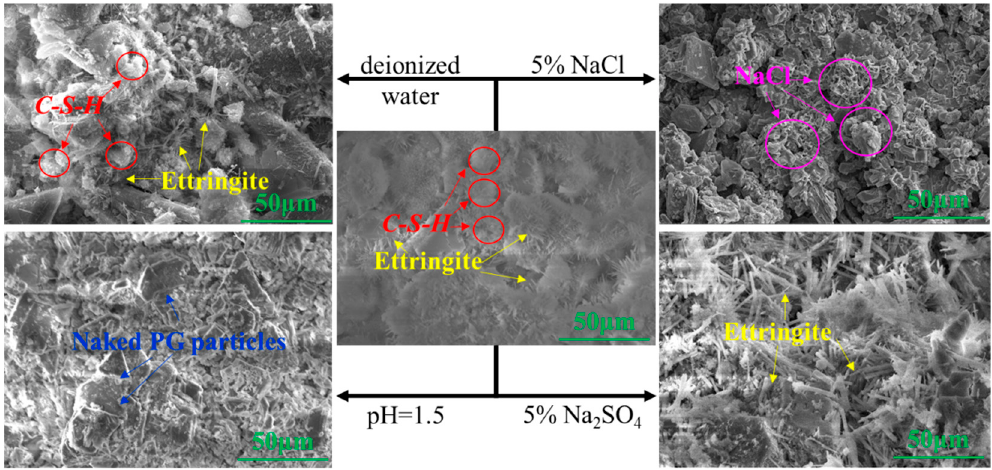
Figure 4. Scanning electron microscope (SEM) images of the PG-based backfill specimens with 120 d curing age and different exposure solutions after 30 drying-wetting cycles. Magnification factor: 2500×; accelerating voltage: 10.00 kV; and working distance: 6.0 mm.